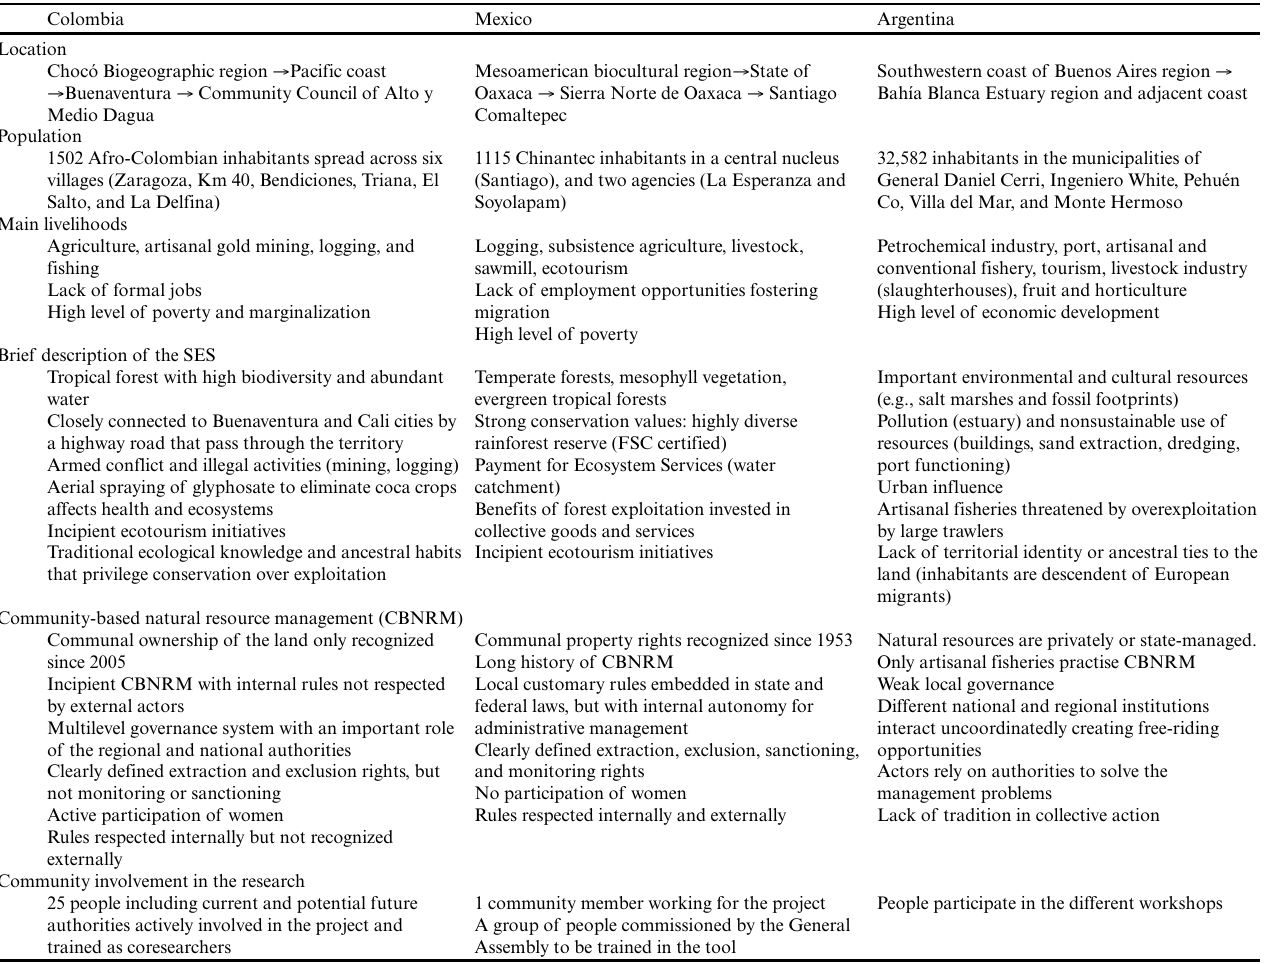
Table 1 . Description of the social-ecological systems (SES).